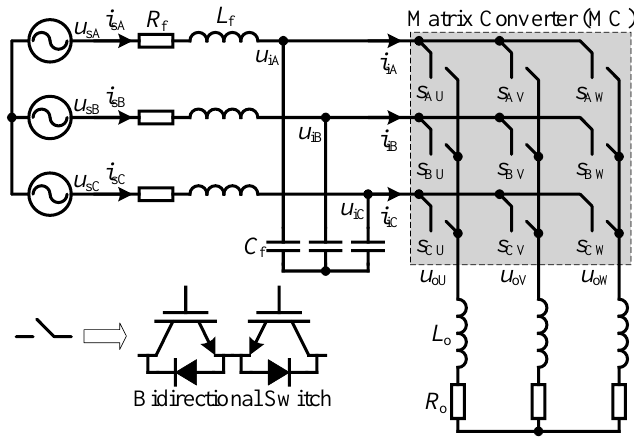
Figure 1. Basic schematic of the matrix converter (MC).